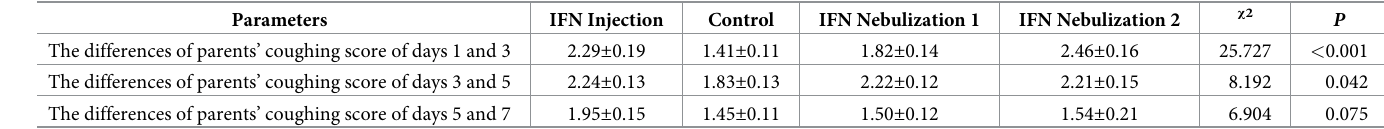
Table 6. The comparisons for the differences in coughing scores as assessed by the parents among the four groups by Kruskal—Wallis test.